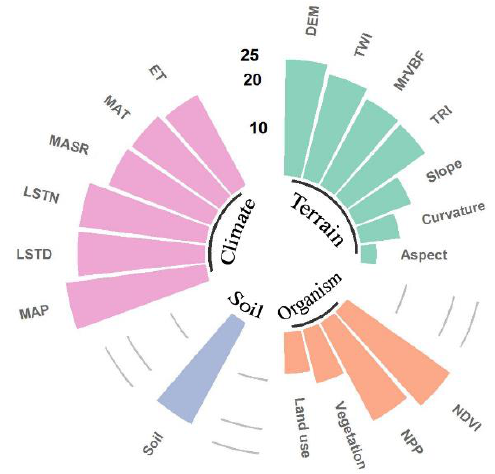
Figure 3. Relative importance of covariates for predicting TN.